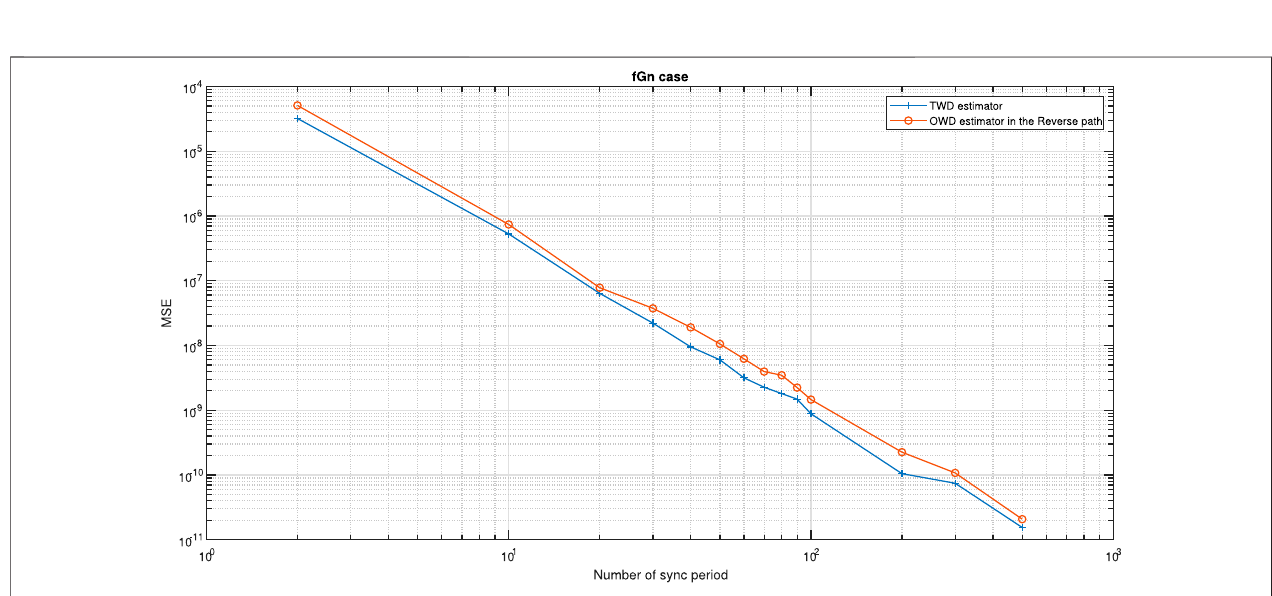
) , H = 0.7, d σ 2 (cid:2) 6 . 4 e − 7 [ sec 2 ] , ω 1 ms = 5 ms , d sm = 5.5 ms , sec